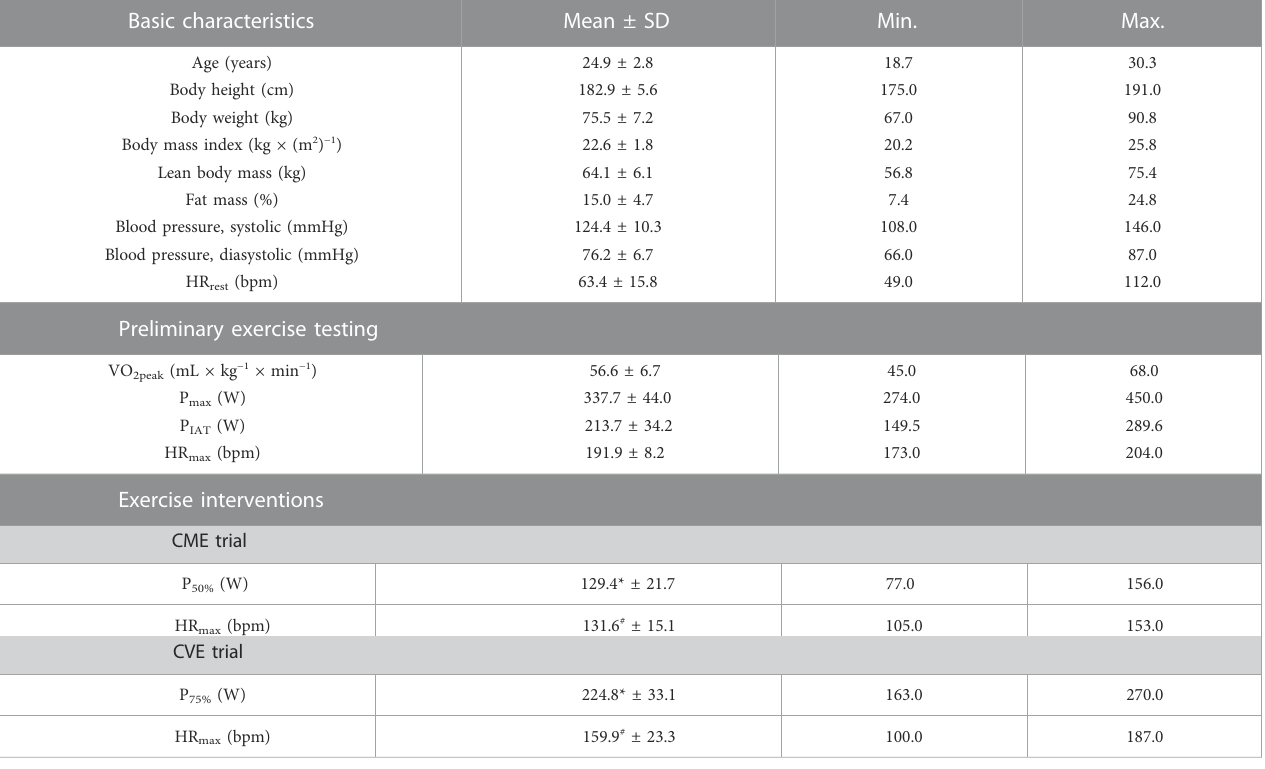
TABLE 1 Descriptive characteristics of participants ( n = 16) and exercise parameters. Basic